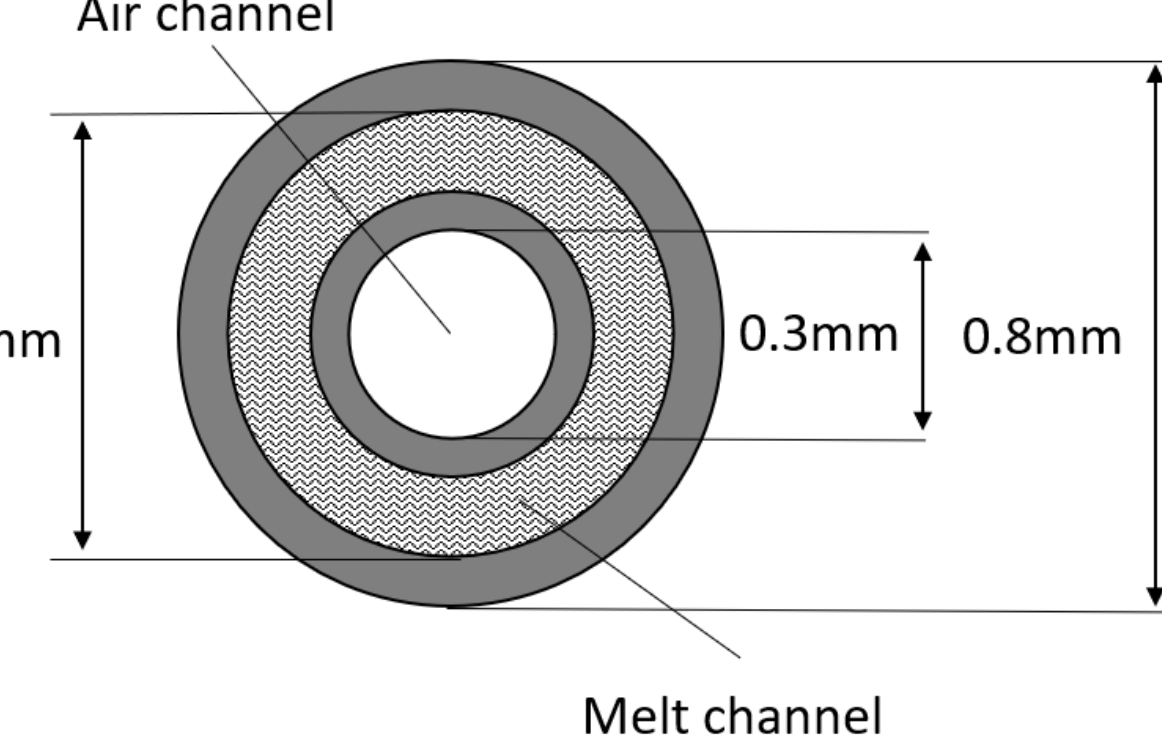
Figure 3. Scheme of coaxial holes of spinneret for the HFs preparation. The following setup and melt spinning parameters were used (see Table Table 1. Setup and melt spinning parameters for obtaining HF based on PMP. Volumetric Poly-